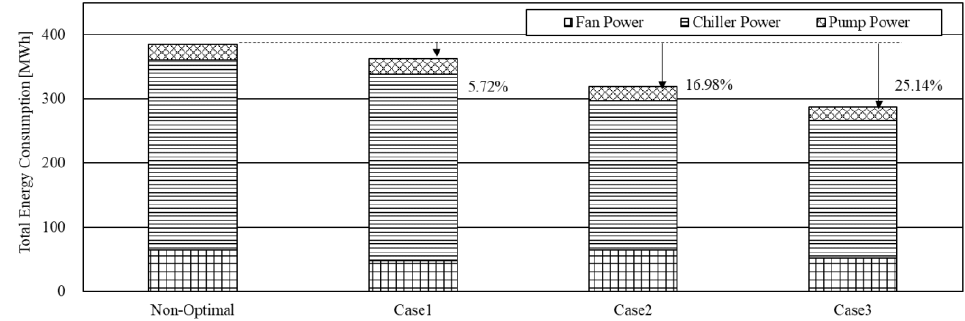
Figure 9. Comparison of total energy consumption between normal operation mode and optimal operation modes for June through September.